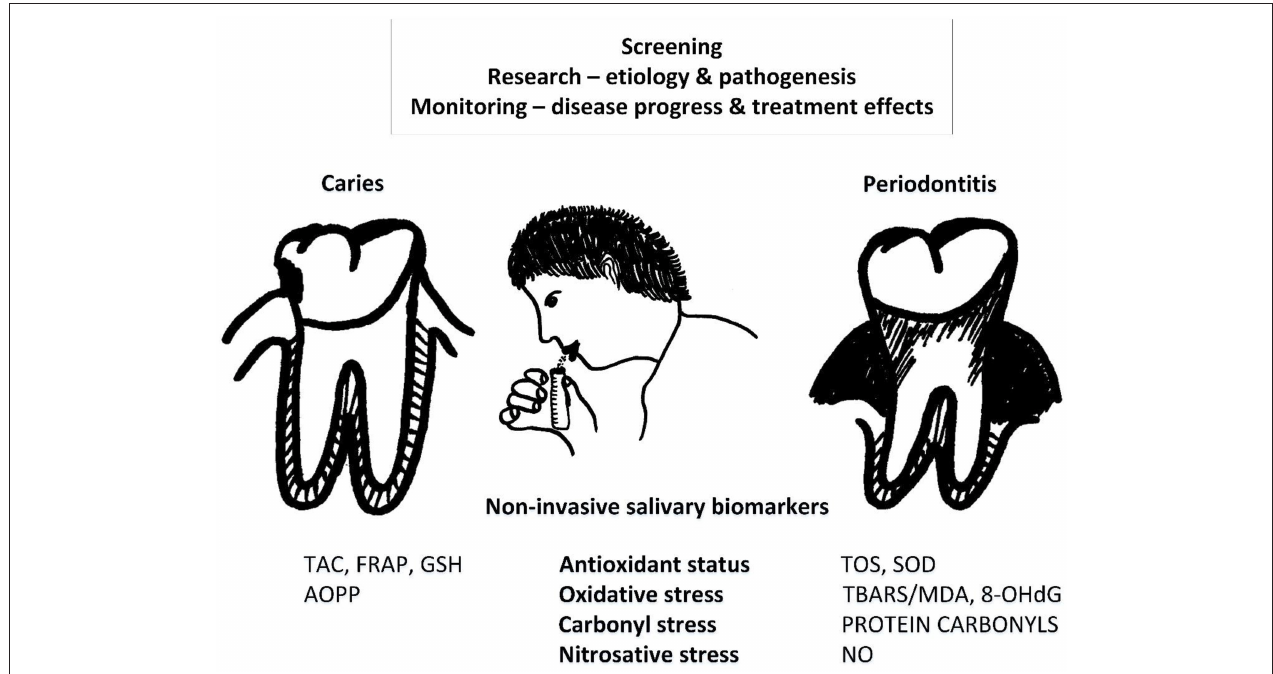
FIGURE 1 | Potential for non-invasive use of salivary biomarkers associated with caries and periodontitis. Saliva can be used for disease screening, monitoring of progress, and treatment as well as in basic research on etiology or pathogenesis. 8-OHdG, 8-hydroxyguanosine; AOPP, advanced oxidation protein products; FRAP, ferric reducing antioxidant power; NO, nitric oxide; TAC, total antioxidant capacity; TBARS/MDA, thiobarbituric acid reacting substances/malondialdehyde; TOS, total oxidant status; SOD, superoxide dismutase.